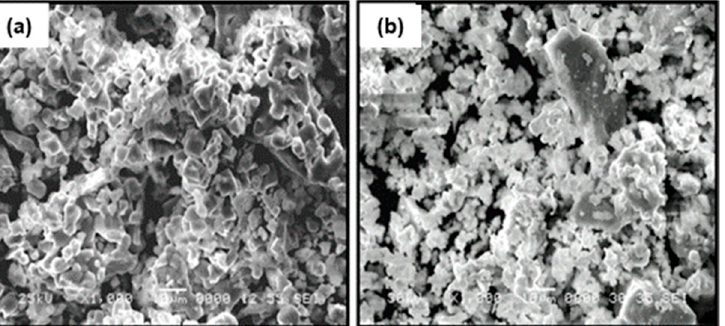
Figure 3. SEM micrographs of the surface of ( a ) sintered La 0.5 Li 0.5 TiO 3 and ( b ) non-sintered La 0.5 Li 0.5 TiO 3 pellets. La 0.5 Li 0.5 TiO 3